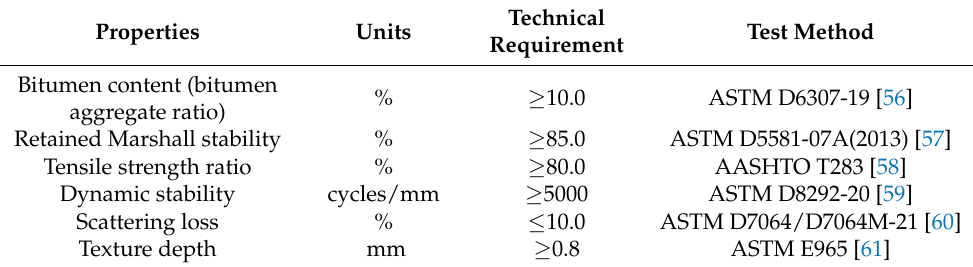
Table 6. Technical requirements of HCUP-8